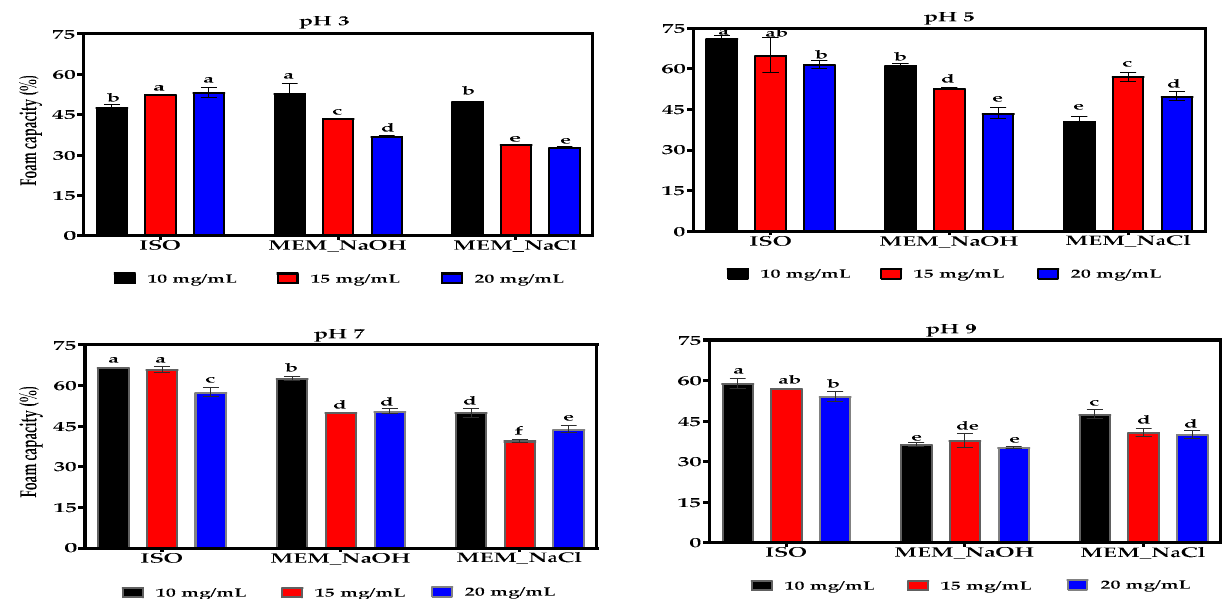
Figure 9. Effect of pH and protein concentration on the foaming capacity of isoelectric pH precipitated isolate (ISO), and membrane isolated proteins from alkaline (MEM_NaOH) and salt (MEM_NaCl) solution extracts. At each pH, bars with different letters have significantly different ( p < 0.05) mean values.